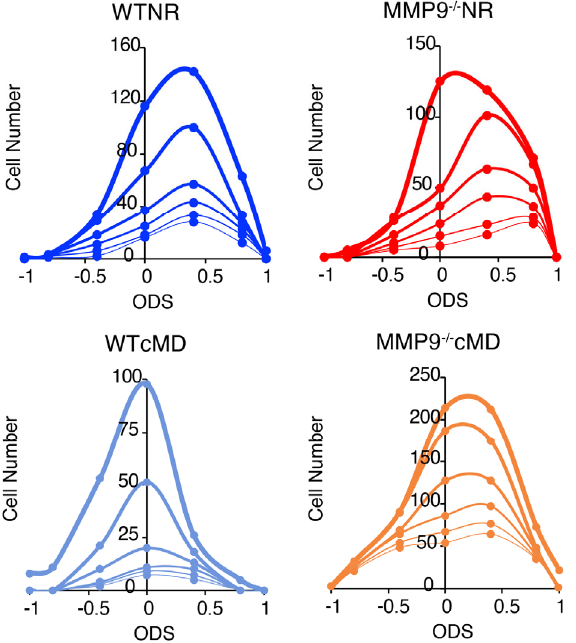
Figure 4. Distributions of ocular dominance scores are independent of the criterion for neuronal visual responsivity. Number of neurons in different ODS categories (ODS = 1, 1 > ODS ≥ 0.6, 0.6 > ODS ≥ 0.2, 0.2 > ODS ≥ − 0.2, − 0.2 > ODS ≥ − 0.6, − 0.6 > ODS ≥ − 1, and ODS = − 1) following different inclusion criteria for visually ‐ responsive neuronal activity (thickest to thinnest lines: 3x, 4x, 5x, 6x, 7x, and 8x STD of baseline).